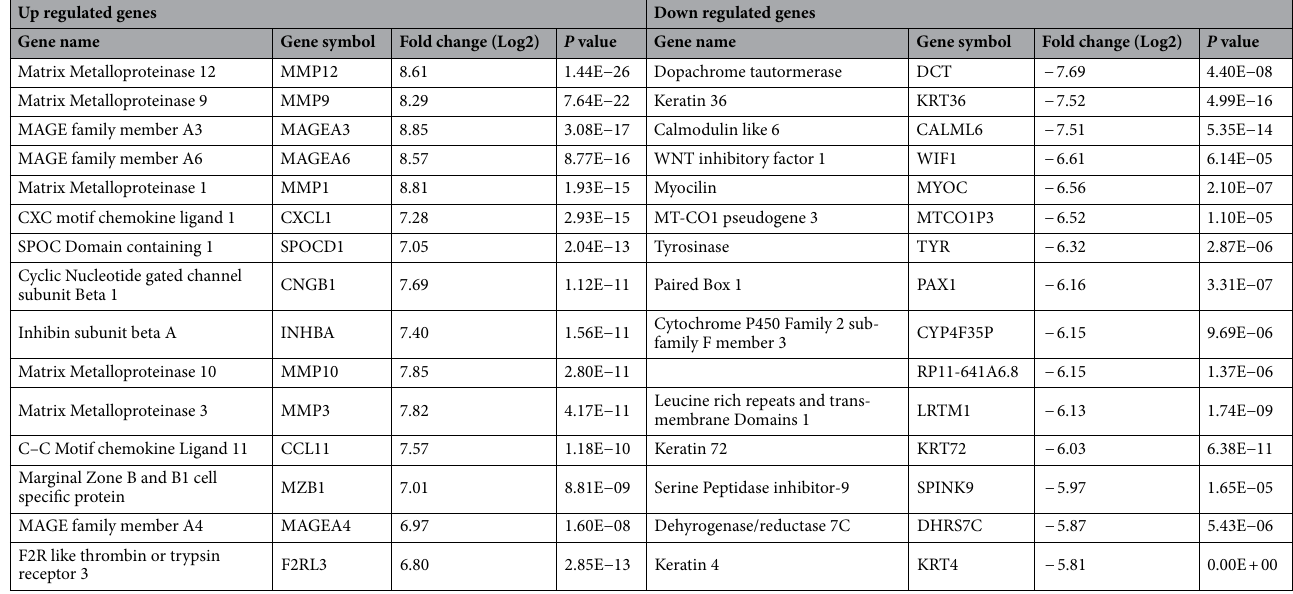
Table 1. Top 15 upregulated and down regulated genes in OTSCC identified by transcriptome